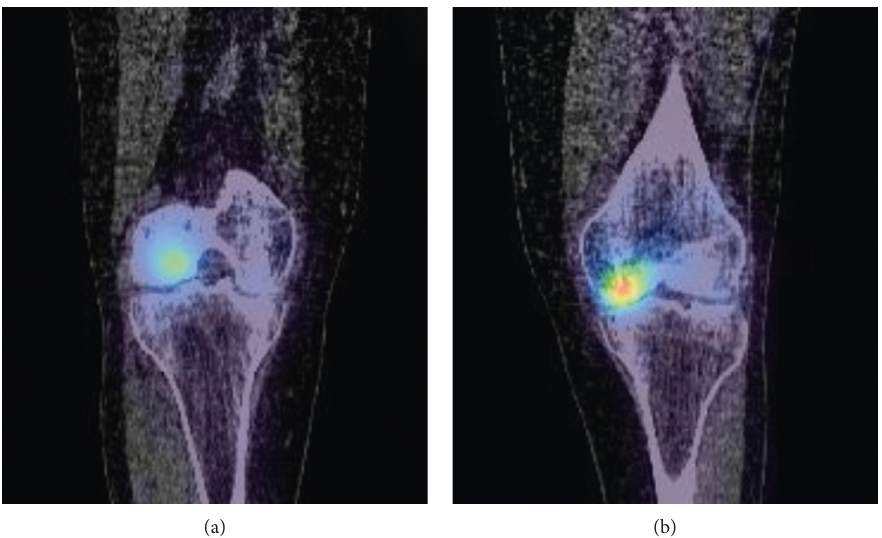
Figure 3: (a) and (b) Sagittal CT component of SPECT showing increased focal tracer uptake in the left medial femoral condyle.